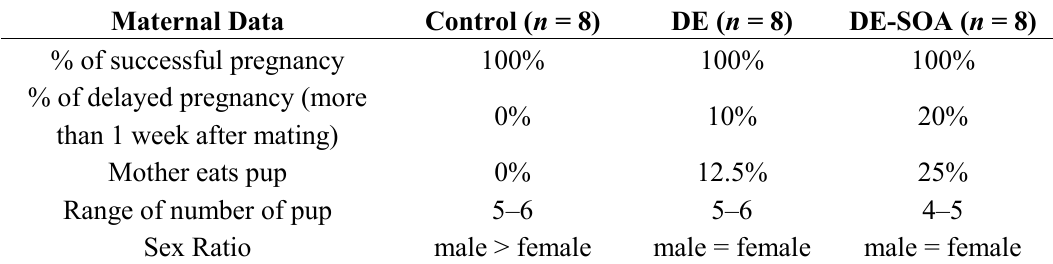
Table 4. Maternal data before and after